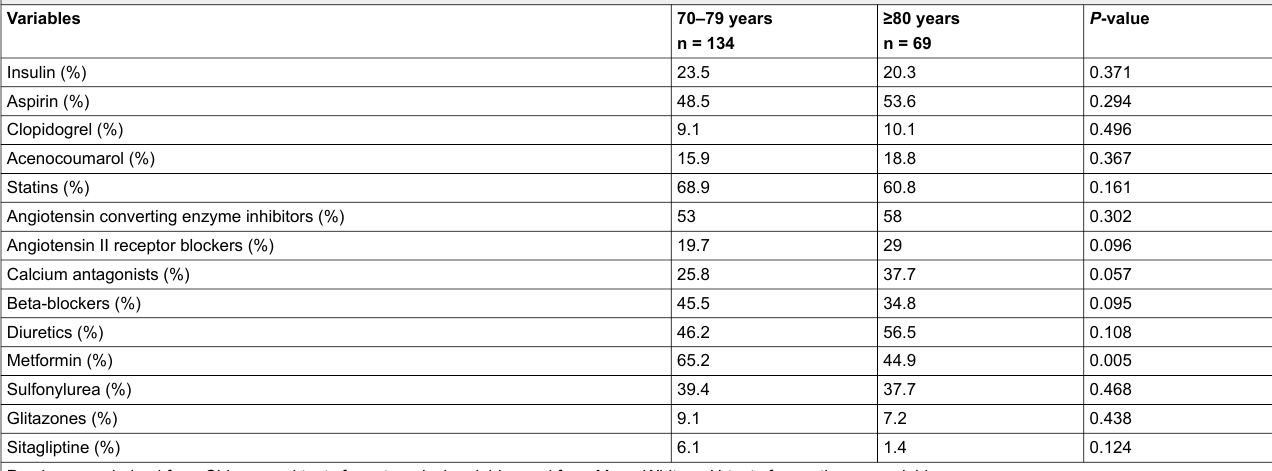
Table 3: Comparison of HbA1c, lipid and renal parameters between age groups. Variables